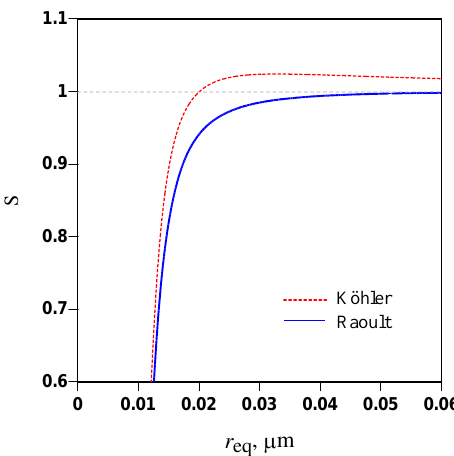
Figure 9: Relationship between the ambient relative humidity and equilibrium size for an ammonium sulfate particle with 0.01µm dry radius. The red dashed curve is the Köhler curve, which includes both the Kelvin effect and Raout effect, whereas the blue curve considers only the Raoult effect. The grey dashed line indicates 100% relative humidity.